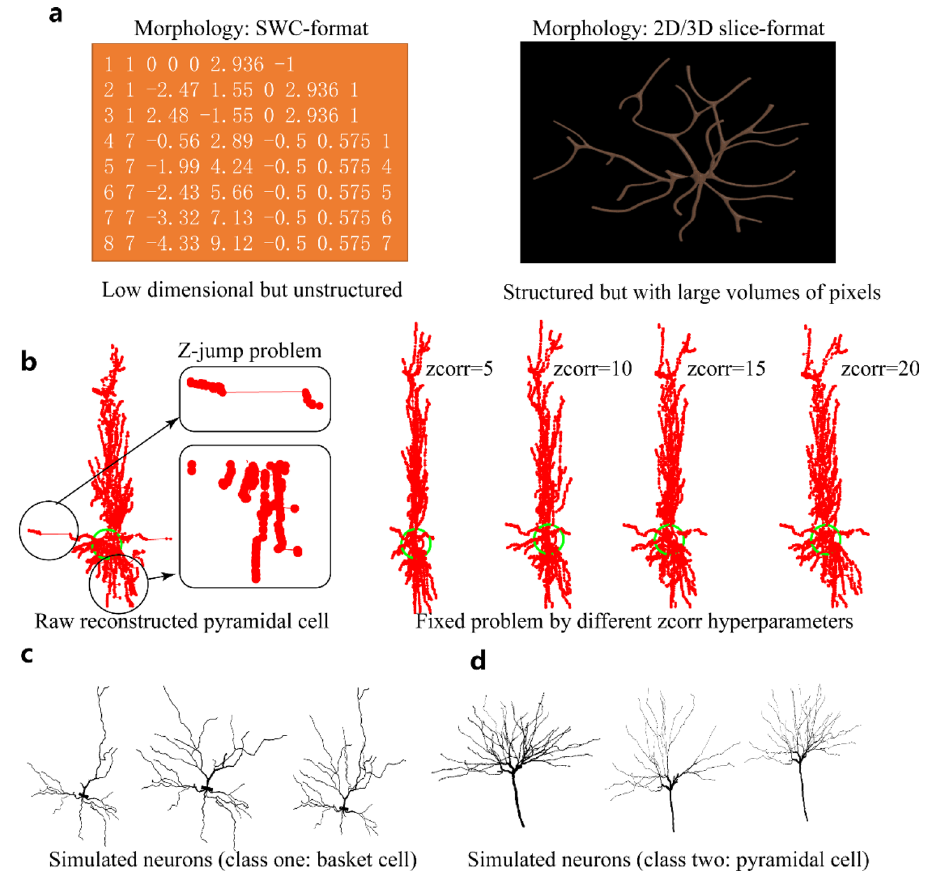
Figure 1. ( a ) Comparisons of the two main formats of neuronal morphology. ( b ) Morphological repairment of a single neuron by the Trees toolbox with different hyperparameters of the “zcorr” method. ( c ) Virtual simulated basket-type neuron samples containing different branch orders generated with Trees toolbox. ( d ) Generated pyramidal-type neurons with Trees